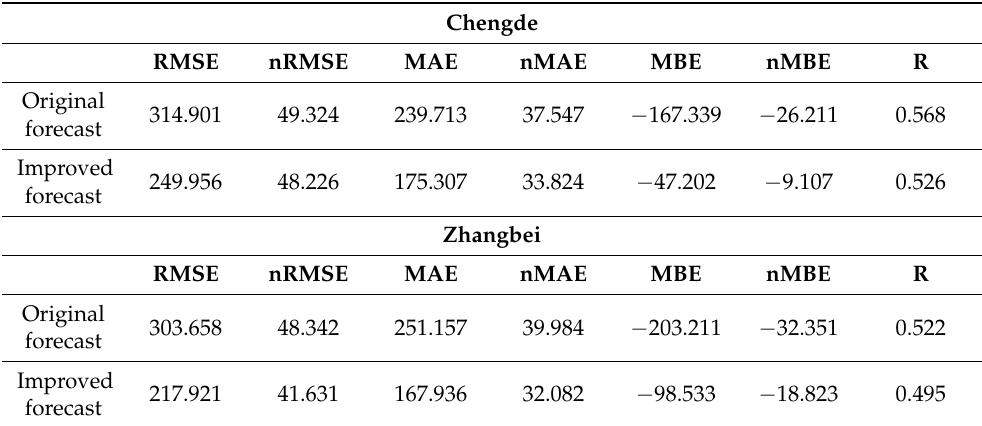
Figure 8. The improved results of the DNI under all sky conditions for 108 continuous samples of the test set (top: Chengde; bottom: Zhangbei). Table 3. DNI correction effect analysis from September to May of the second year (W/m 2 for the RMSE, MAE, MBE, and mean